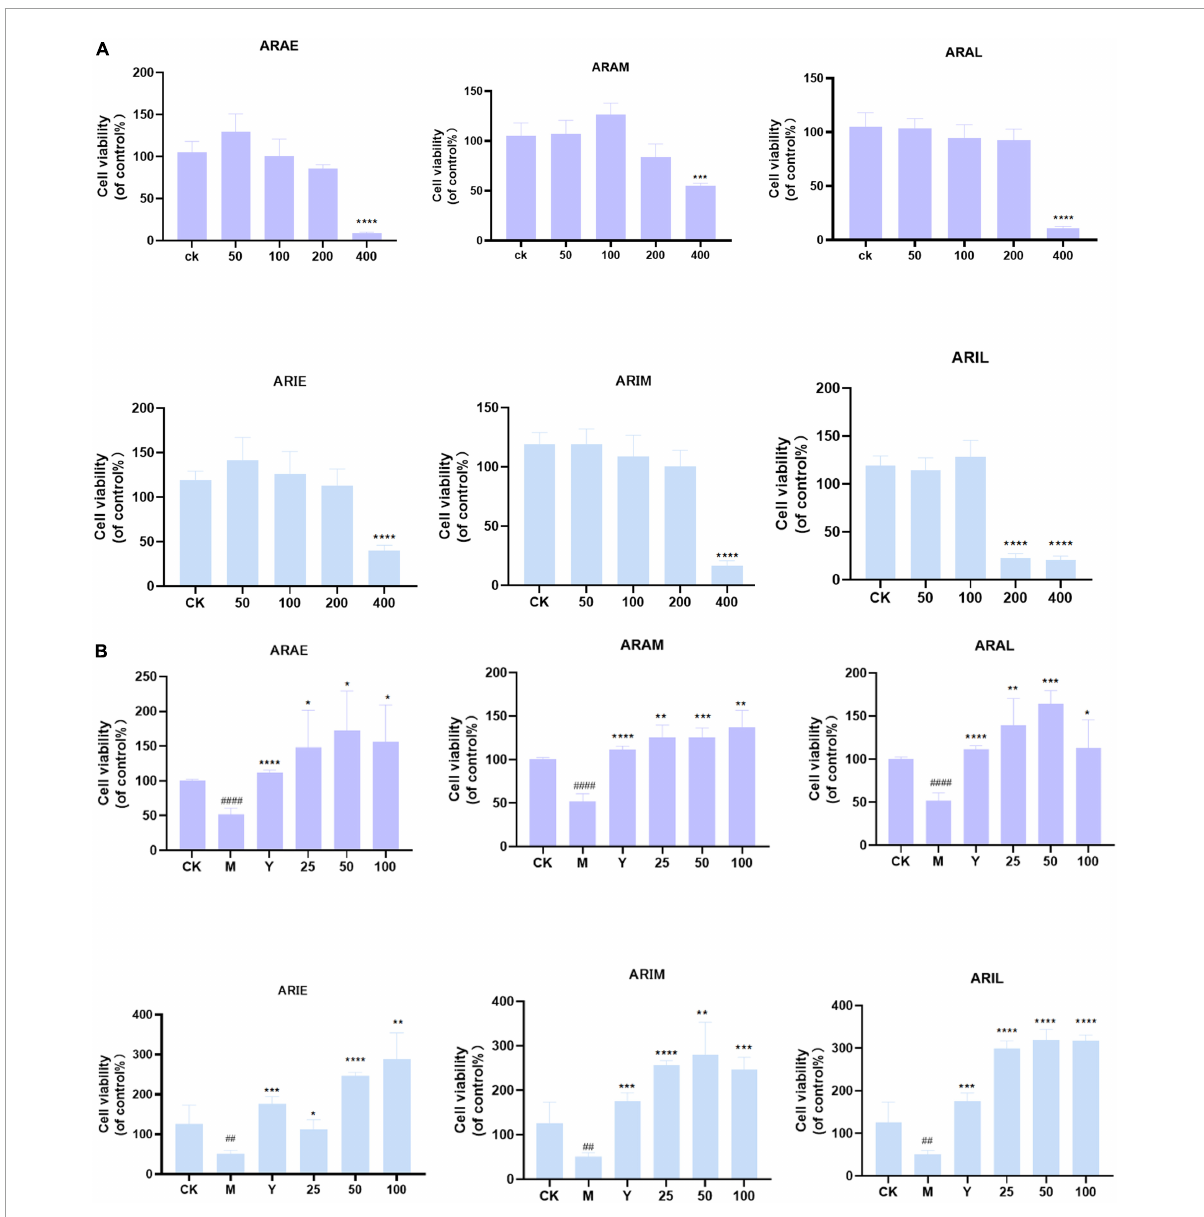
FIGURE11 Effect of toxicity (A) and activity (B) of A. argyi and A. indica on survival rate of RAW264.7 macrophages. A. argyi and A. indica between 0 and 100 µ g/ml had no toxic effect on RAW264.7 cells. The activity of ARAL was higher than that of ARAE and ARAM, and that of ARIL was higher than that of ARIE and ARIM in RAW2647 macrophages (means ± SD, n = 3 ). **** P < 0.0001, *** P < 0.001, ** P < 0.01, * P < 0.1 compared with control group. #### P < 0.0001, # P < 0.1 compared with that of the control